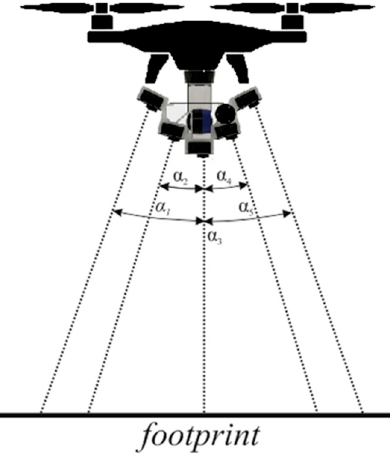
Figure 3. Imaging geometry for UAV multi-camera imaging system.